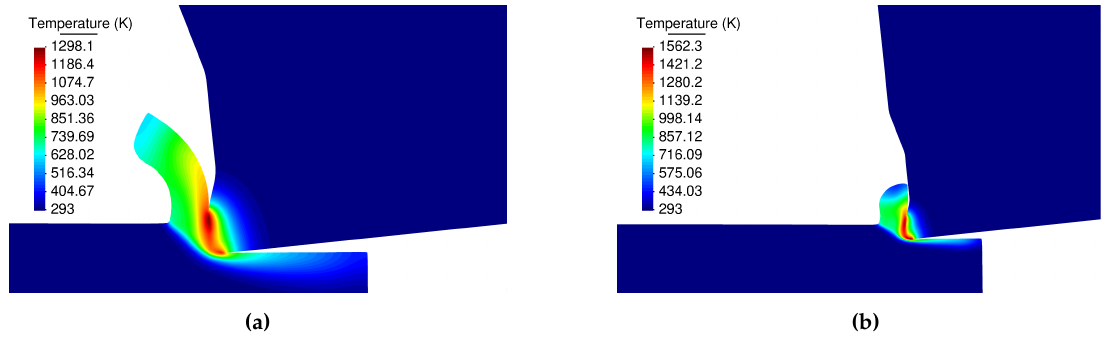
Figure 15. Temperature field; ( a ) the dislocation density, ( b ) the Johnson-Cook